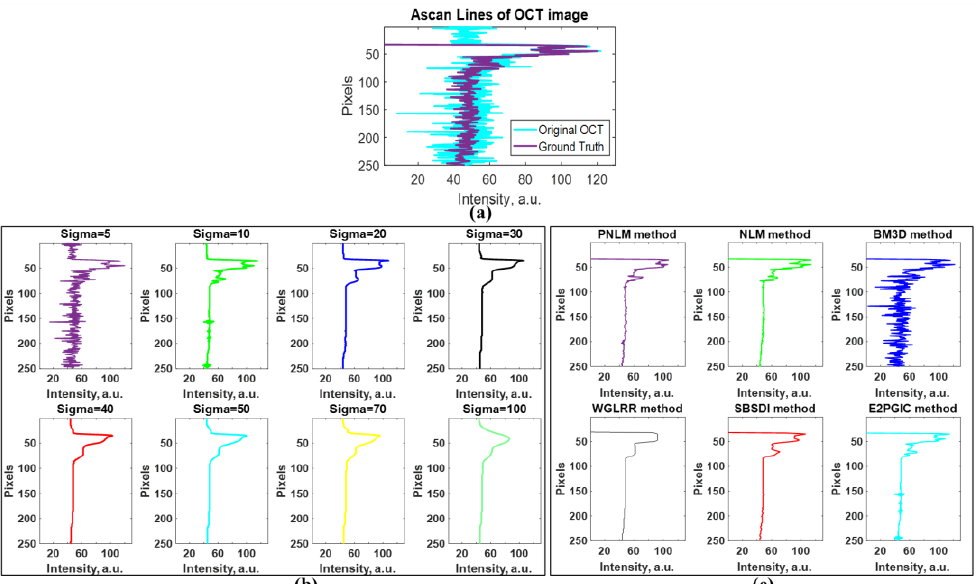
Figure 3. The A-scan lines of original, ground truth, and denoised OCT images. ( a ) The A-scan lines of the original OCT image and ground truth. ( b ) The A-scan lines of the denoised OCT images with different estimations of the noisy standard deviation ( σ = 5, 10, 20, 30, 40, 50, 70, and 100). ( c ) The different noise reduction methods used the A-scan lines of the denoised OCT images.